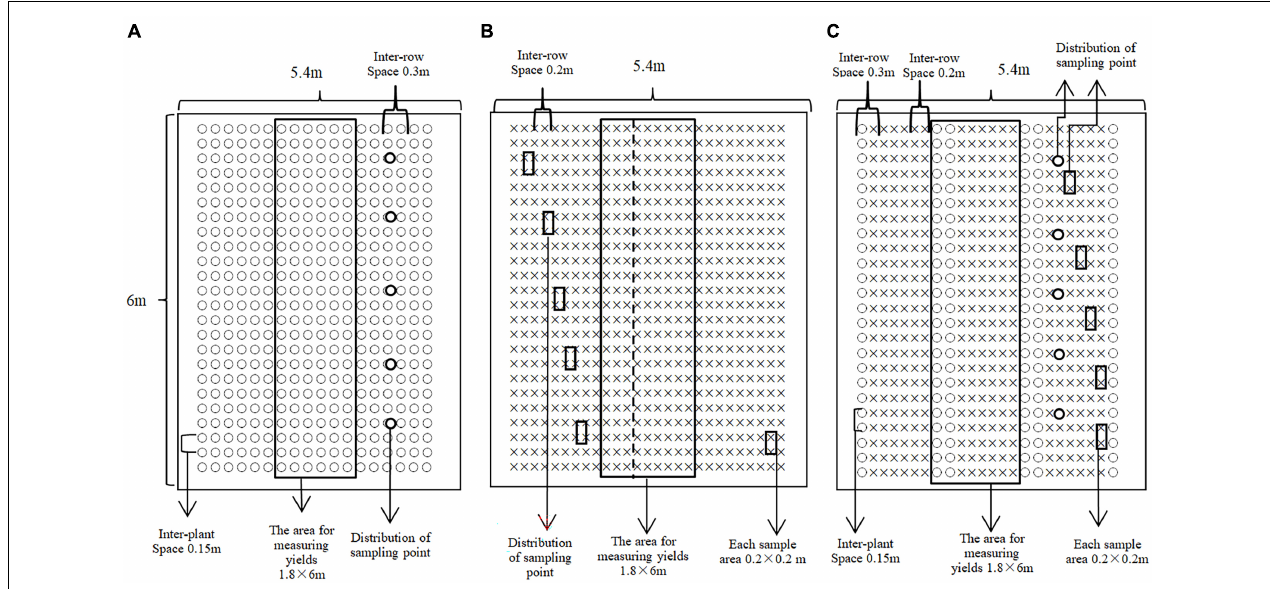
FIGURE 1 | Plot diagram of planting pattern in field plot experiment: (A) plot map of monocropped faba bean plot; (B) plot map of monocropped wheat plot; and (C) plot map of intercropped faba bean/wheat (O represents faba bean and X represents